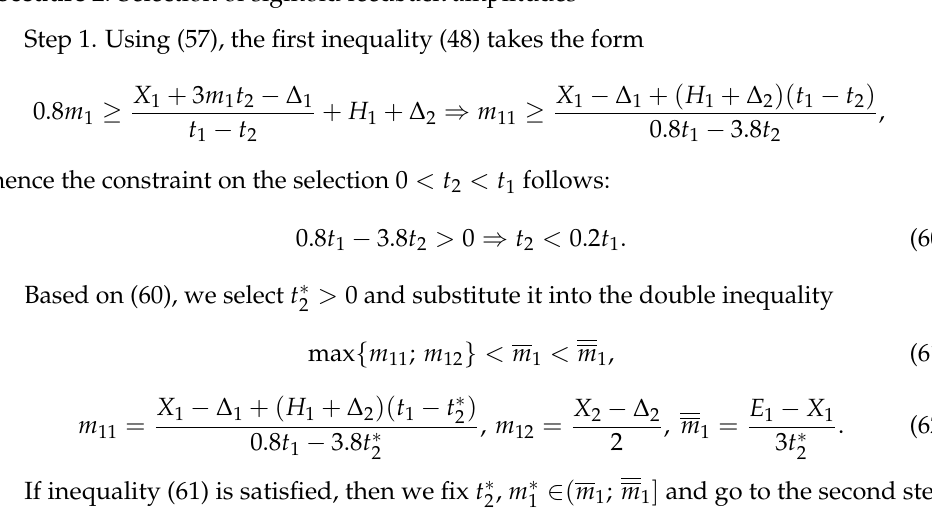
Procedure 2 . Selection of sigmoid feedback